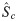
Phenotype transition success and ancestry.(a) Transitions to deterministic assemblies have high success, tending to perfect in an infinite population. Conversely, transitions to nondeterministic assemblies (marked with *) typically have less success. Transition rates between nondeterministic assemblies vary considerably, due to the varying overlap between the interfaces of an ancestor and the stronger interfaces of the descendant. Interaction strength is indicated by line thickness. The transition locations in phase space of ancestors are shown for the heterotetramer and 12-mer in (b) and (c) respectively. (b) For transitions from both the dimer and homotetramer, one bond has been strengthened through evolution (black) and one is new and at the critical interaction strength S^c (gray). Compared to the evolutionary equilibrium of the heterotetramer, the dimer has a much more favorable ratio of strengths than the homotetramer, as indicated by its closer position in phase space. Likewise in (c), the evolutionary equilibrium of the octomer has much more similar ratios of interaction strength to the 12-mer than the heterotetramer has. In addition to the heterotetramer being further down the determinism gradient, it more frequently misassembles the phenotype, lowering its transition success even further.